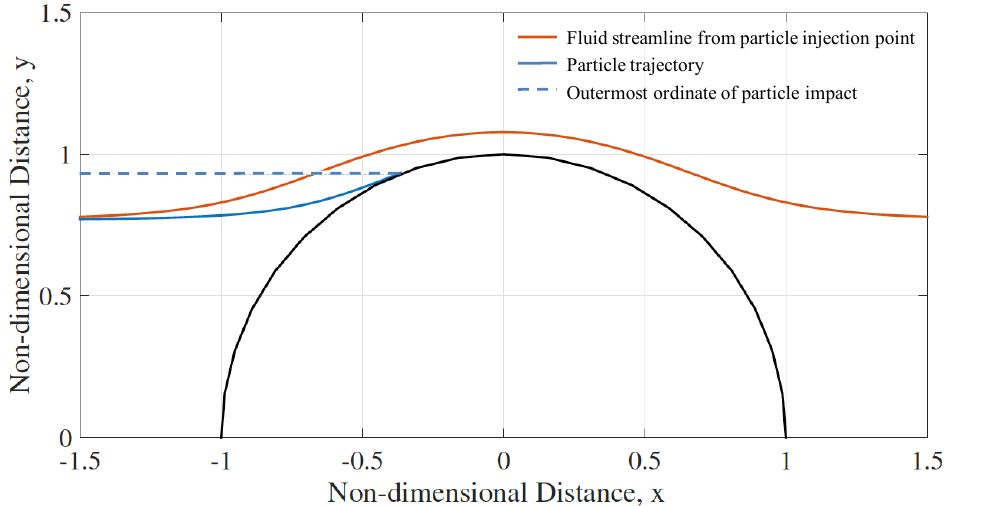
Figure 4. Impingement of the outermost trajectory of particles injected with an initial particle Reynolds number of 100, Stokes number of 1, and non-Stokes drag parameter, φ , of 1000. The fluid streamline from injection point is also shown, illustrating an impact efficiency of around 0.93 for this